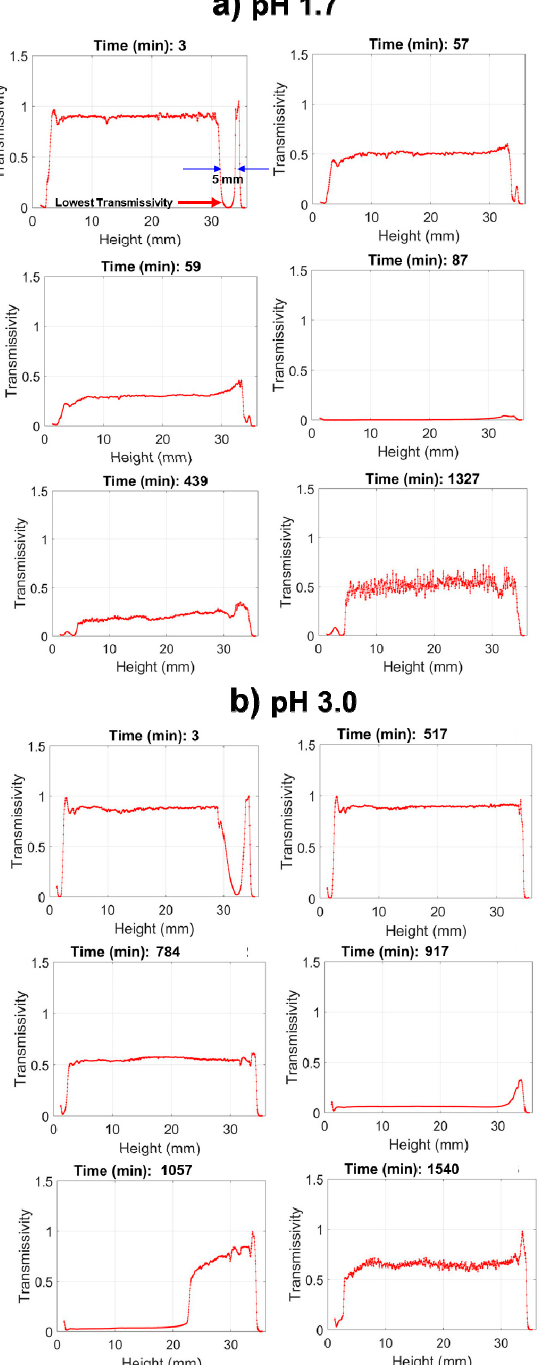
Figure 4. Turbidity scanning of the sol-gel reaction for nPM in water at pH 1.7 ( a ) and pH 3.0 ( b ). The graphs show light transmission vs. tube height, with 0 mm representing the bottom of the reaction tube. The lens of neat silane occupies the top ~ 5 mm of the 35 mm tube height, causing the dip in transmission seen at early times near the top of the tube. Hydrolysis solubilizes the silane, and the thickness of the lens narrows with time. Condensation in the bulk is observed by the drop in light transmission through the entire length of the